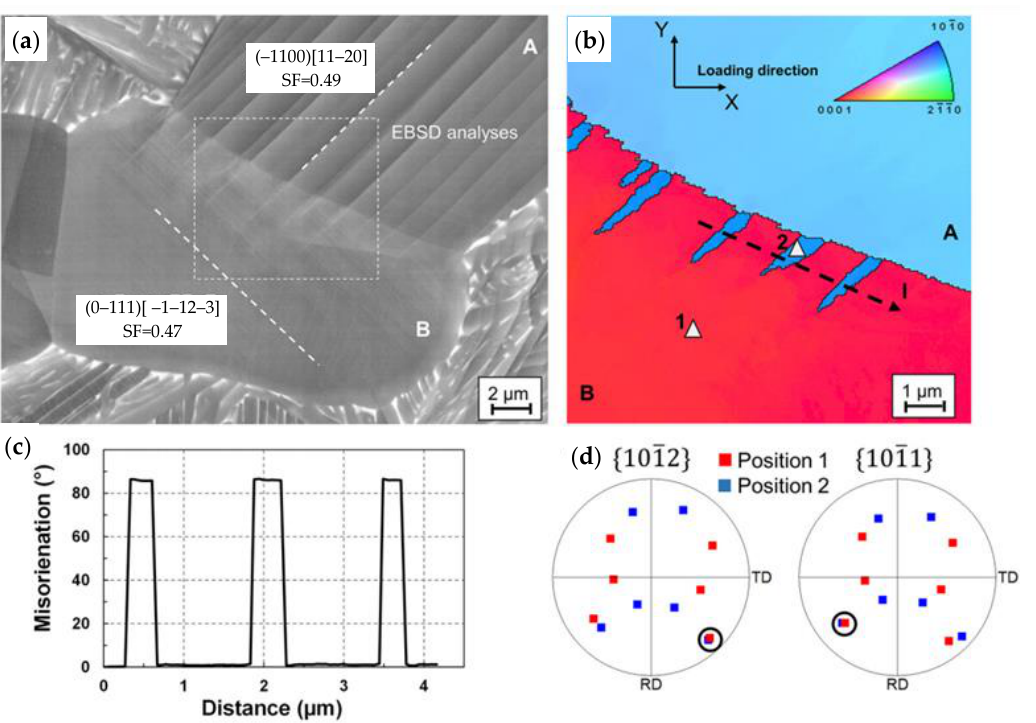
Figure 9. ( a ) SEM micrograph of twinning caused by slip transfer in a pair of grains; ( b ) the corresponding IPF map along the loading direction; ( c ) the misorientation profile along path I; ( d ) {10–12} and {10–11} pole figures at positions 1 and 2 [94].